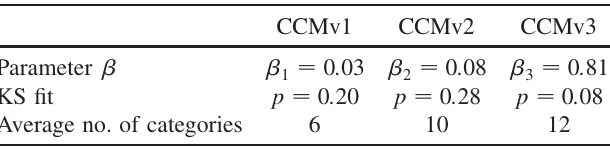
TABLE II. CCM model